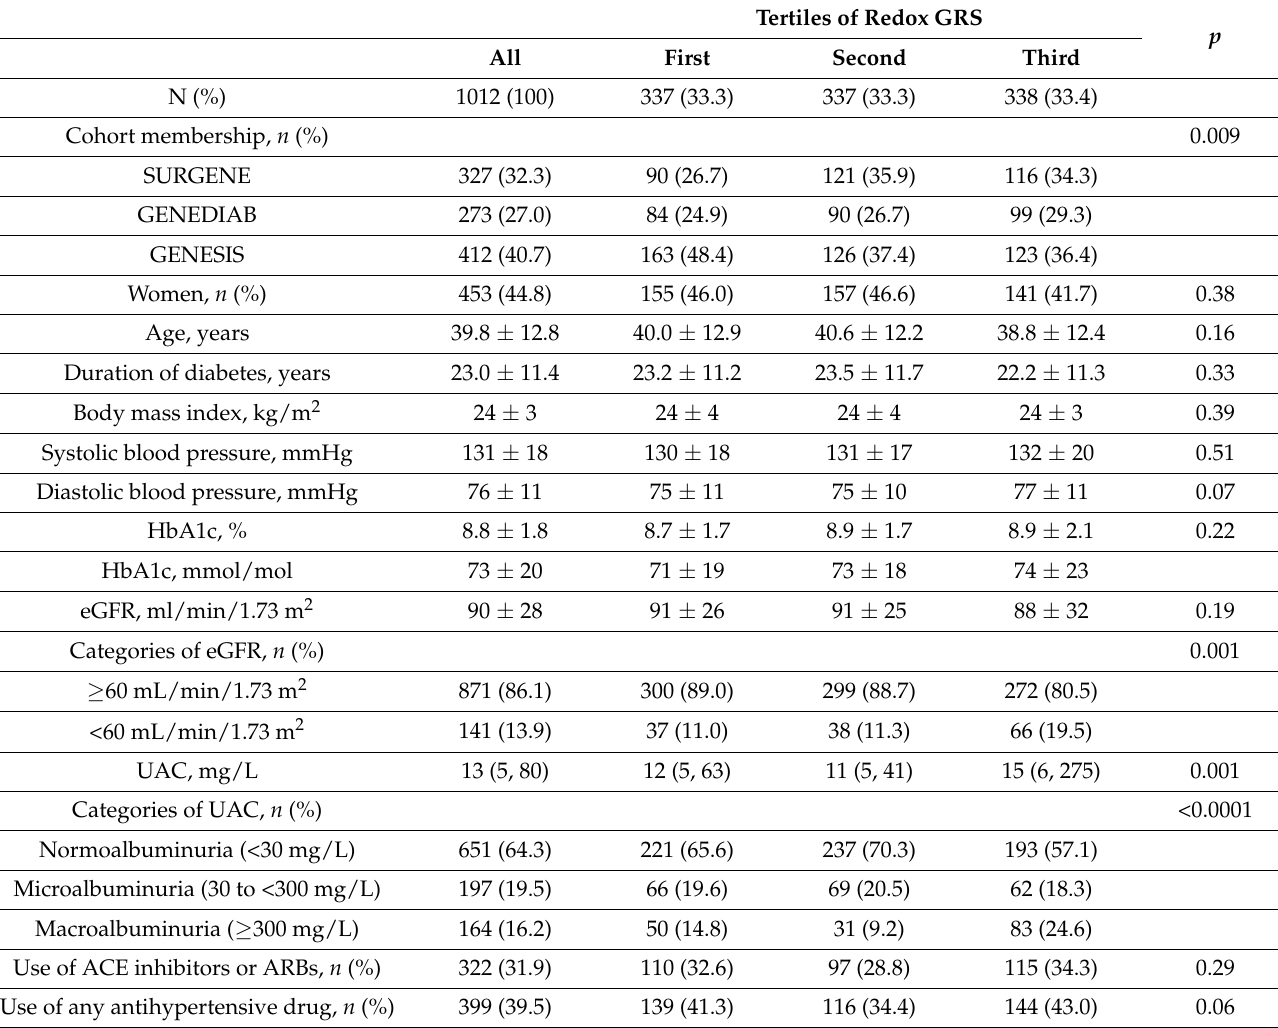
Table 1. Characteristics of participants at baseline according to tertiles of redox genetic risk score.